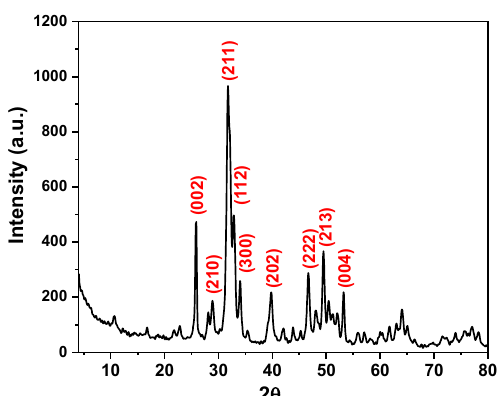
Figure 1. X-ray diffraction (XRD) pattern of nano-hydroxyapatite (n-HAP).